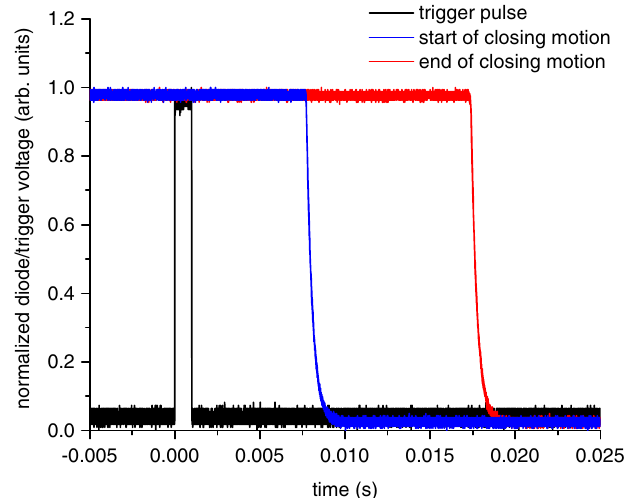
FIG. 4. (Color) Normalized trigger and diode traces. The rising edge of the black trace indicates the valve trigger event, the blue trace shows the onset of valve closure, and the red curve indicates full valve closure.